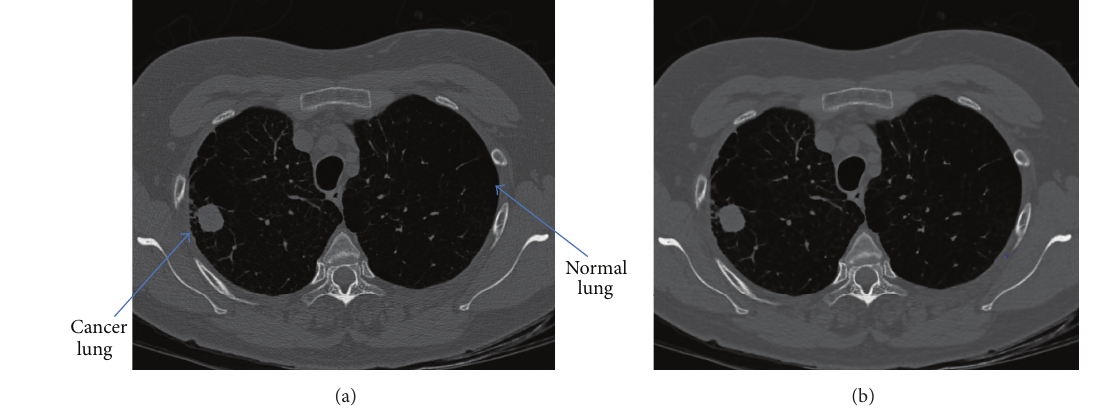
Figure 2: Image preprocessing: (a) original image and (b) filtered image.